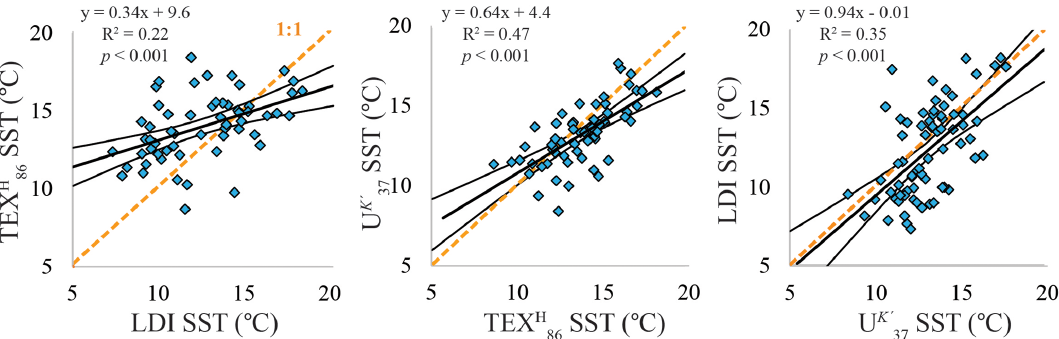
(cid:48) index, U K index, and LDI. Linear regressions are 86 37